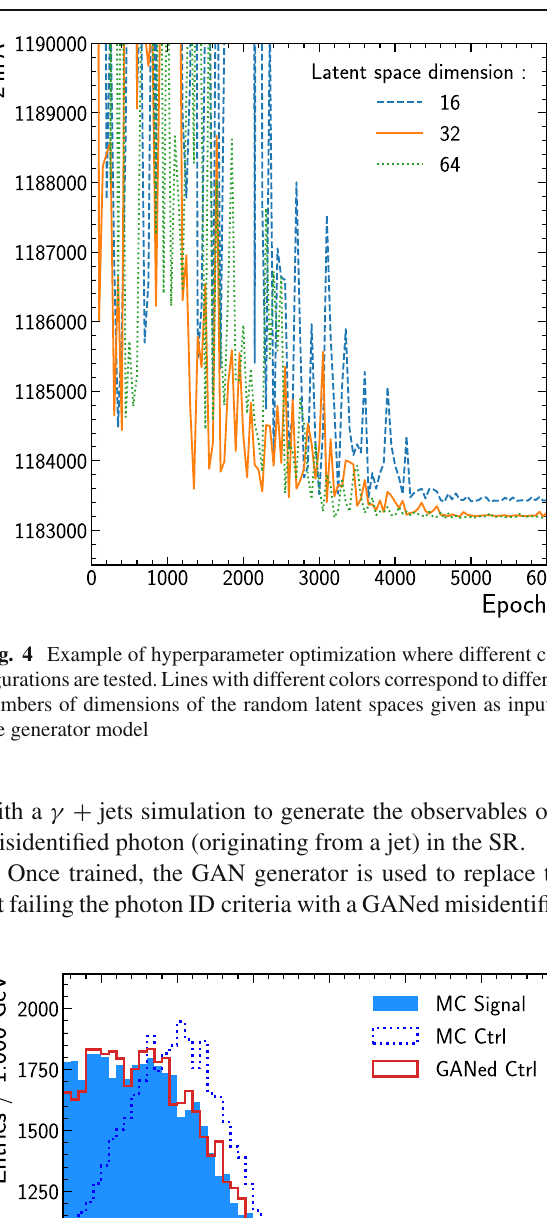
with a γ + jets simulation to generate the observables of a misidentified photon (originating from a jet) in the SR.